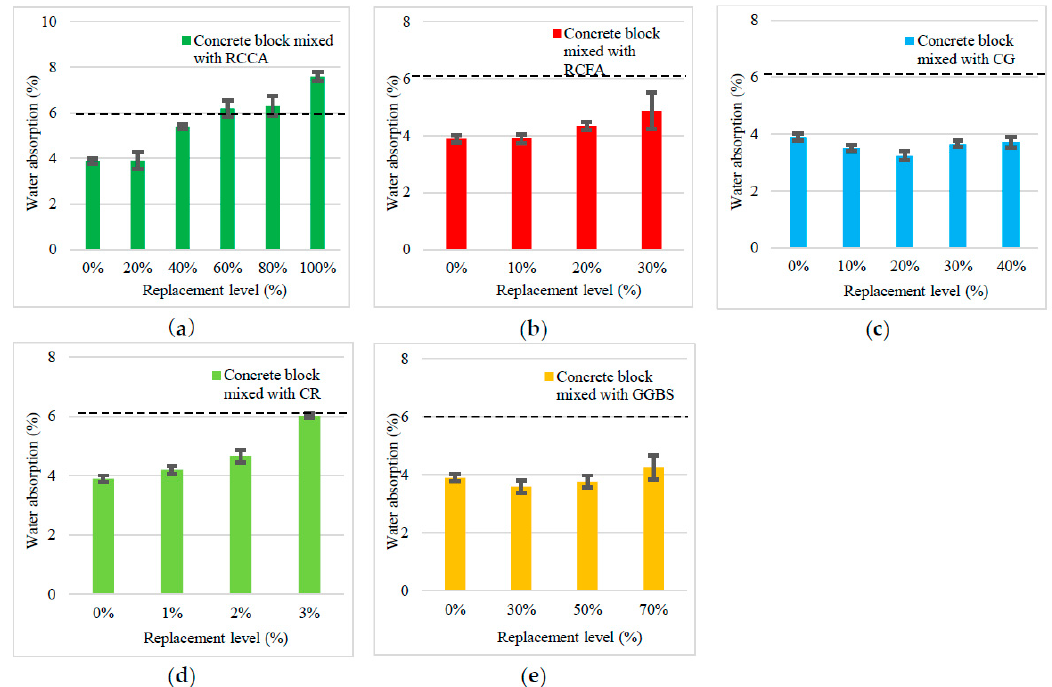
Figure 10. Relationship between the different replacement levels of materials and the water absorption of specimens. Appl. Sci. 2019 , 0 , x FOR PEER REVIEW